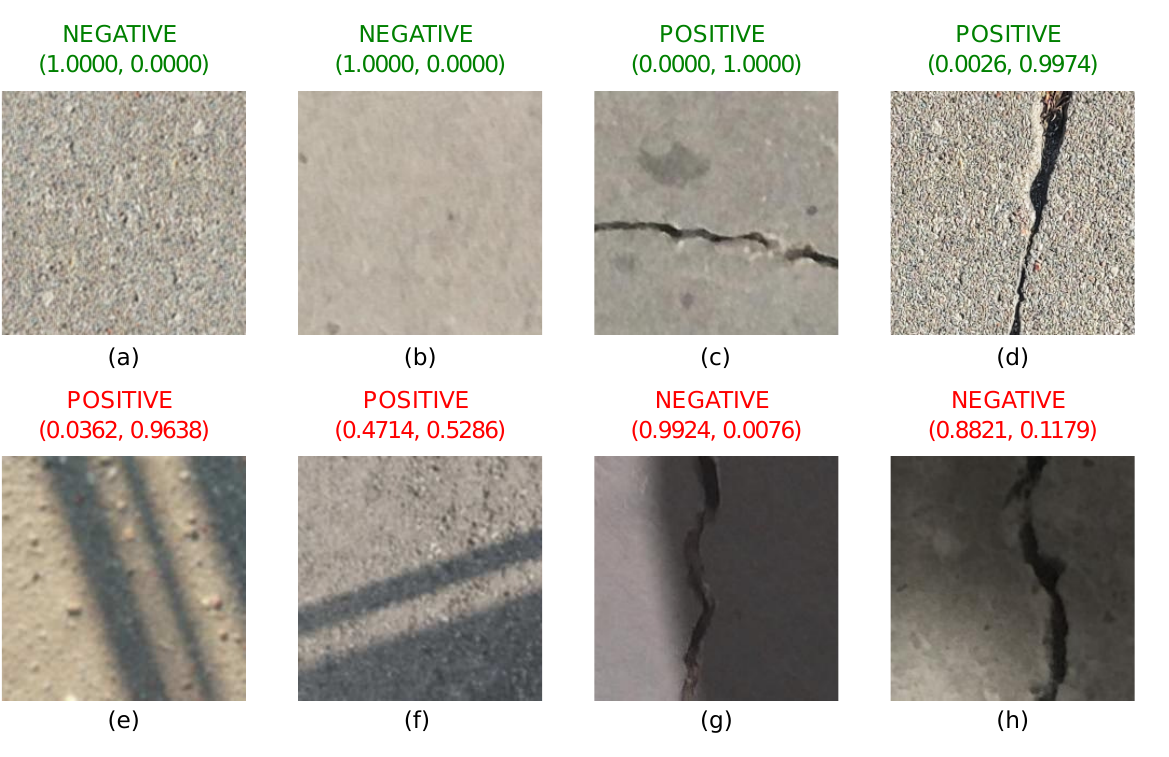
Figure 3. The model trained on the original Mendeley “Concrete Crack Images for Classification” produces wrong results in the presence of shadows. Images without cracks and shadows in parts ( a , b ) and with cracks and without shadows in parts ( c , d ) are classified correctly. Images without cracks but with shadows in parts ( e , f ) and images with cracks and shadows in parts ( g , h ) are classified incorrectly. Figure highlights the deficiencies of the standard image classification